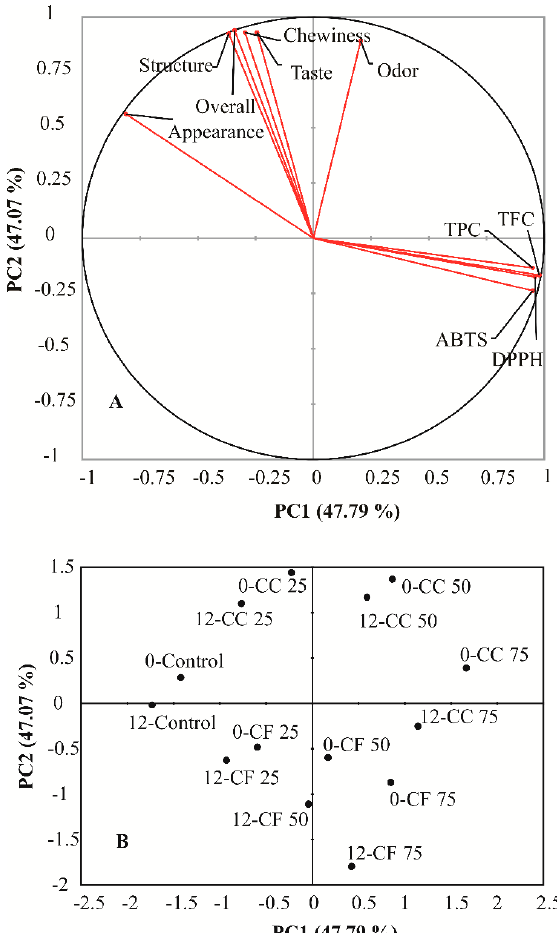
Figure 4. Principal component analysis (PCA) followed by Varimax rotation of samples (PC1 vs. PC2 plane): ( A ) correlation circle of variables and ( B) samples in factor plane (samples at the beginning—prefix “0-“ and after 12 months—prefix “12-“).